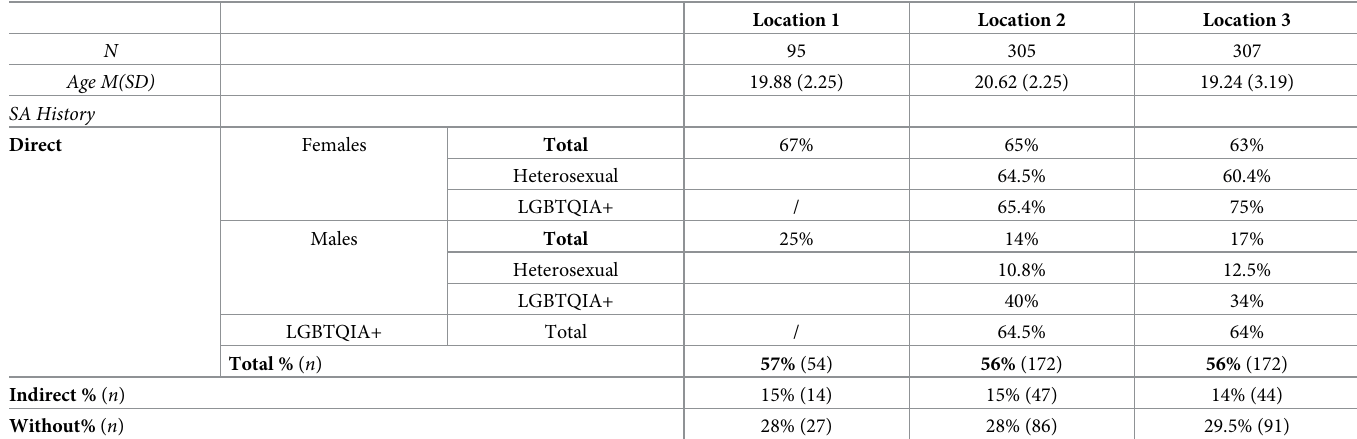
Table 3. Frequency (%) of students’ self-disclosed SA at Location 1, Location 2, and Location